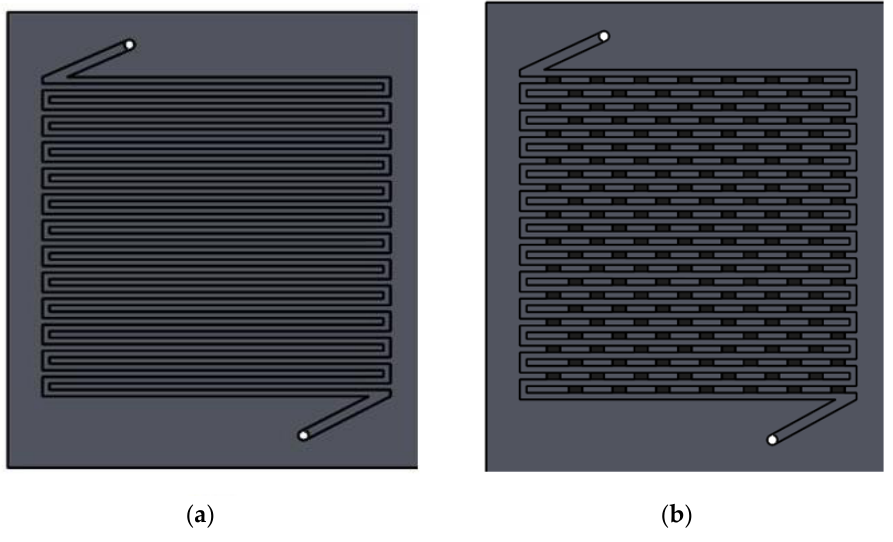
Figure 2. ( a ) SFF ( b ) MSSFF with reaction area of 100 cm 2 .